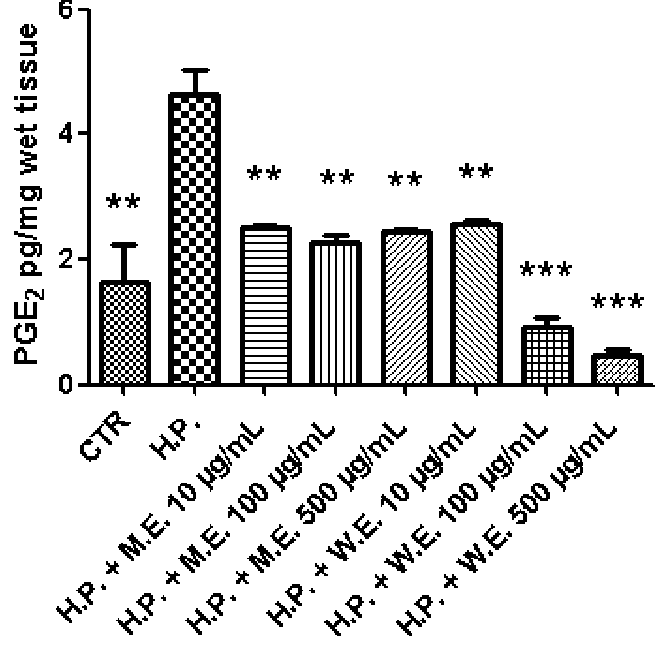
Figure 7. E ff ects of P. foetida methanol (M.E.) and water (W.E.) extracts on hydrogen peroxide 1 mM (H.P.)-induced decrease of PGE 2 release from isolated mouse skin. ANOVA, p < 0.001; ** p < 0.01, *** p < 0.001 vs.